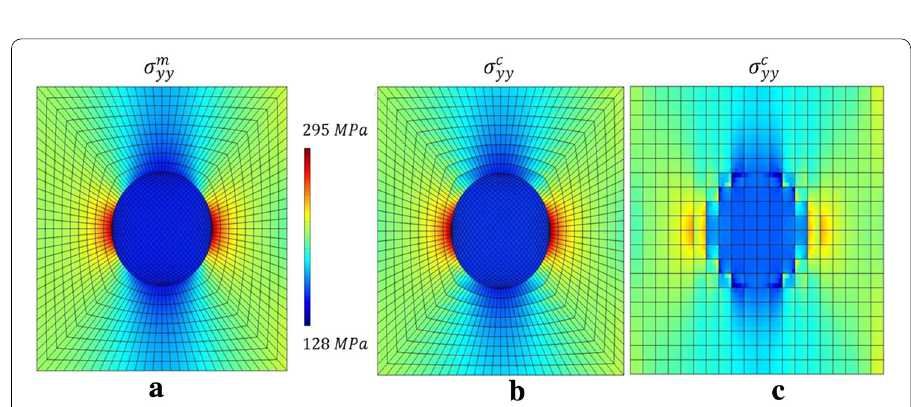
Fig. 3 Identified Young modulus distributions: a 2 “consistent” identification domains and b 400 non-consistent identification domains